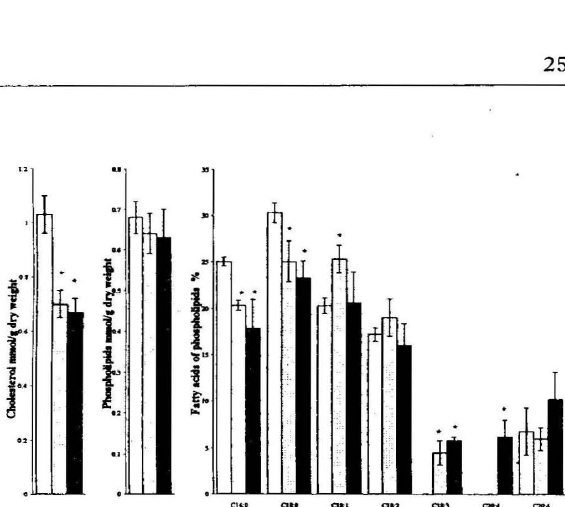
Figure 1. Concentrations (mean±S.D.) of cholesterol and phospholipids, as well as fatty acid content (in per cent: mean ±S.D .) of phospholipids in controls (open bars) and in samples with 5 pmol/g wet weight (dotted bars) or with 30 pmol/g wet weight (hatched bars) 7,8- dihydroneopterin. Samples of rat liver tissue homo genates were used to test for phospholipid biosynthesis in vitro. Incubation medium: Krebs-Ringer-phosphate buffer (pH=7.4), fatty acid mixture and glvcerol. Sam ples were incubated twice for 4 h at 37"C. * The changes are statistically significant (p<0.002